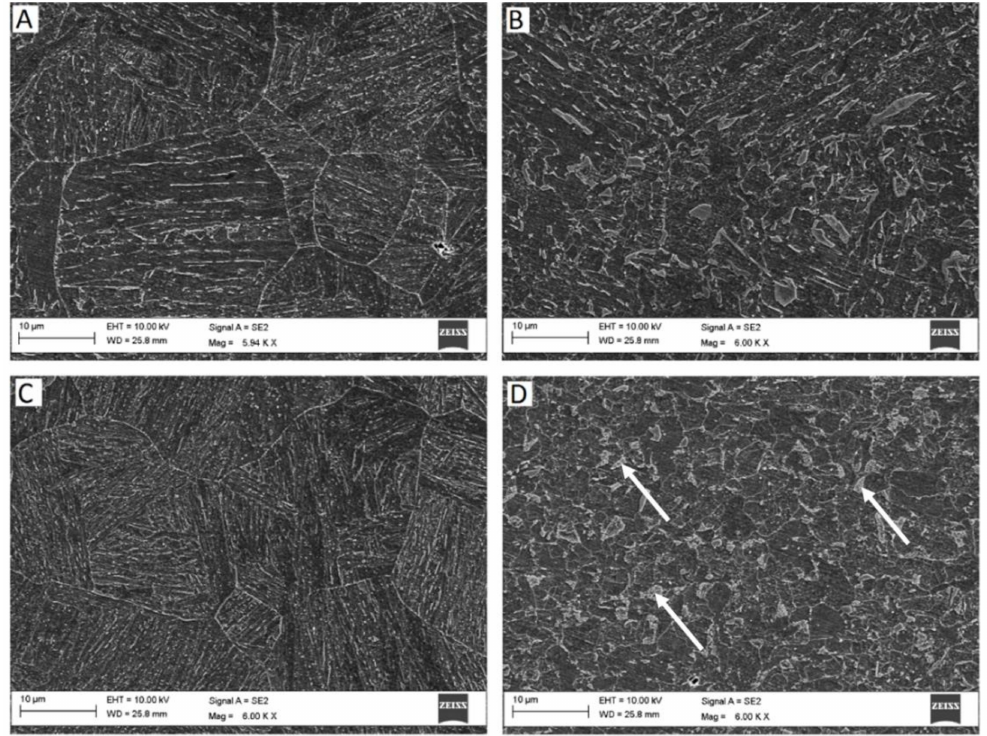
Figure 16. SEM images from low heat input weld (t 8/5 = 5 s) HAZ for steel S700MC-2. ( A – D ) are locations established in Figure